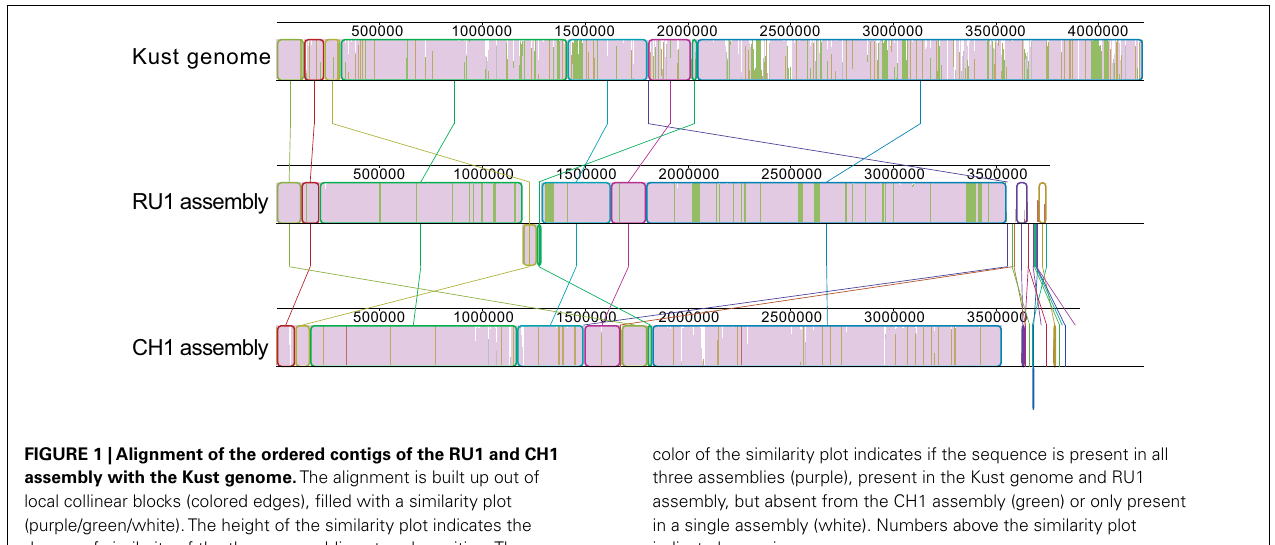
FIGURE 1 |Alignment of the ordered contigs of the RU1 and CH1 assembly with the Kust genome. The alignment is built up out of local collinear blocks (colored edges), filled with a similarity plot (purple/green/white).The height of the similarity plot indicates the degree of similarity of the three assemblies at each position.The